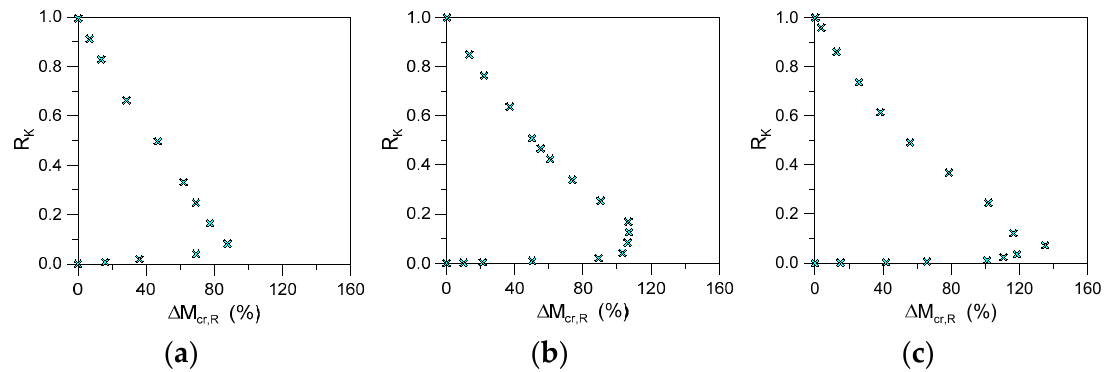
Figure 22. Percentage scatter (Equation (28)) for critical buckling moment estimates of selected LR glass beams ( K = var): ( a ) n b = 3, ( b ) n b = 4, and ( c ) n b = 5.